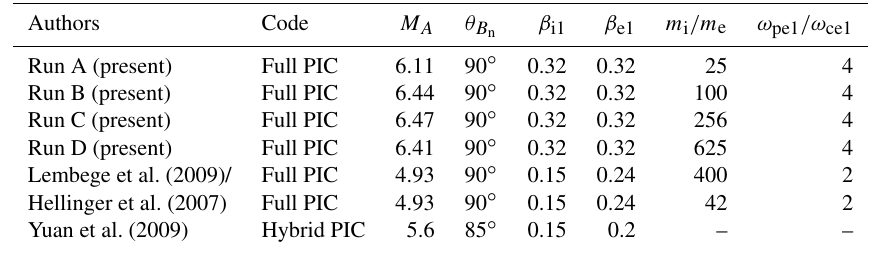
Table 1. Simulation parameters used by different authors. Authors